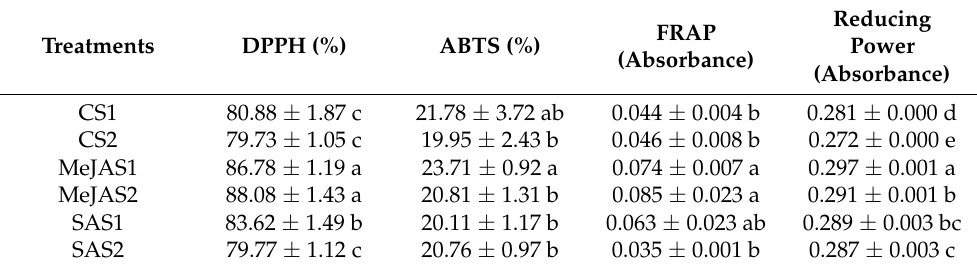
Table 3. The DPPH (2,2-di-phenyl-1-picrylhydrazyl) radical scavenging capacity, Trolox-equivalent antioxidant capacity (ABTS), ferric-reducing antioxidant power (FRAP), and reducing power of ‘Kumato’ tomato cultivar in the control and treatment (0.25 mM MeJA and 0.5 mM SA) groups at two maturity stages.